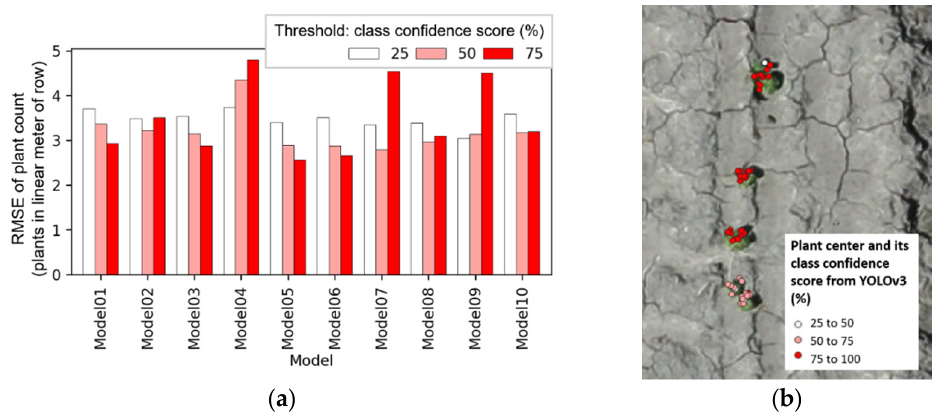
Figure 12. Relation of class confidence threshold and average root mean square error (RMSE) of plant